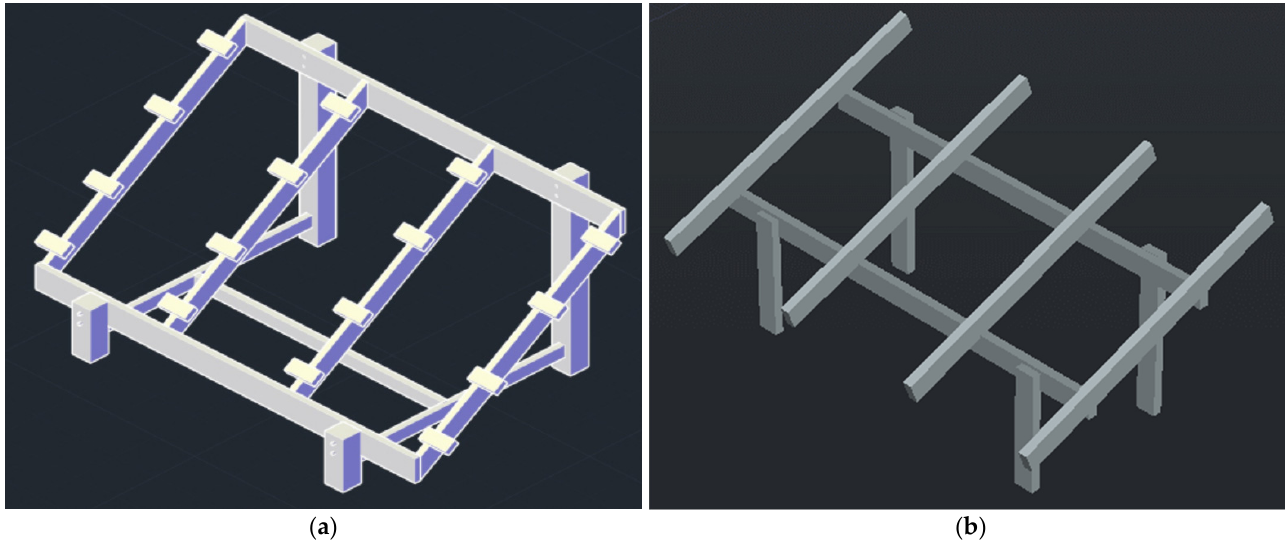
Figure 1. Open hardware PV racking designs made from: ( a ) wood and ( b ) metal. The major components seen in Figure 2 for the wood and metal racking system are nearly identical. The outside joists hold the side of portrait-oriented modules on the far right and far left of both racks. The inside joists do the same for the interior sides of the modules. Both designs have an equivalent number. Both systems have two beams. The wood system has them at the top and bottom of the racking, helping frame the modules. The metal members are parallel, running at about 1/3 and 2/3 of the module. The front and back posts are the upright members perpendicular to the ground that are secured into the ground with the same amount of concrete. They are different lengths in the two